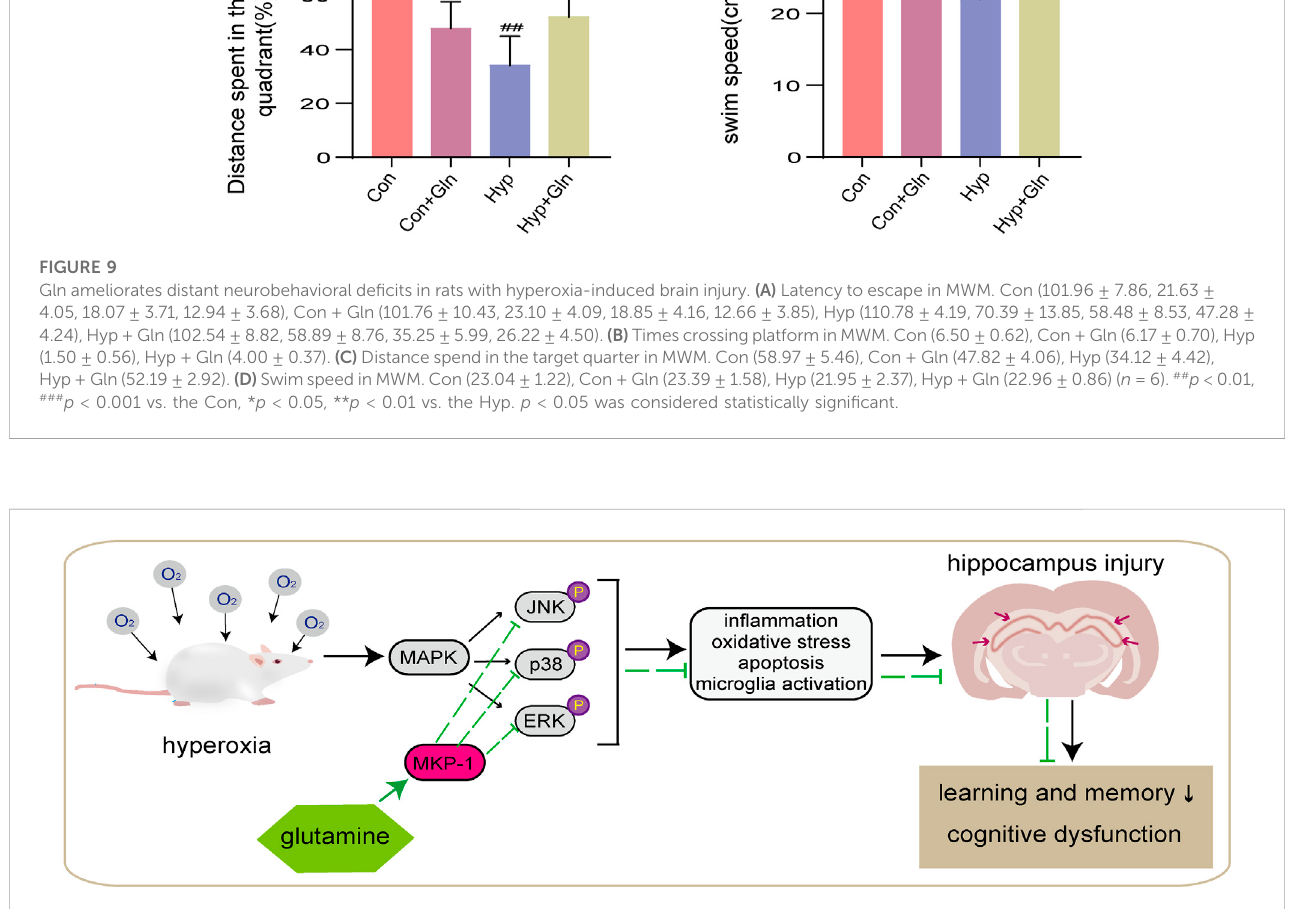
FIGURE 10 Graphical abstract. Hyperoxia can lead to behavioral abnormalities and neurocognitive and learning de fi cits in newborn rats, which is thought to be related to damage to hippocampal neurons caused by oxidative stress, in fl ammation, apoptosis, and microglial overactivation. Gln may induce MKP-1 and thereby inhibit activation of the MAPK signaling pathway, leading to a reduction in oxidative stress, in fl ammation, and apoptosis in cells and attenuating hyperoxia-induced damage to cerebral tissue, and improve learning and memory